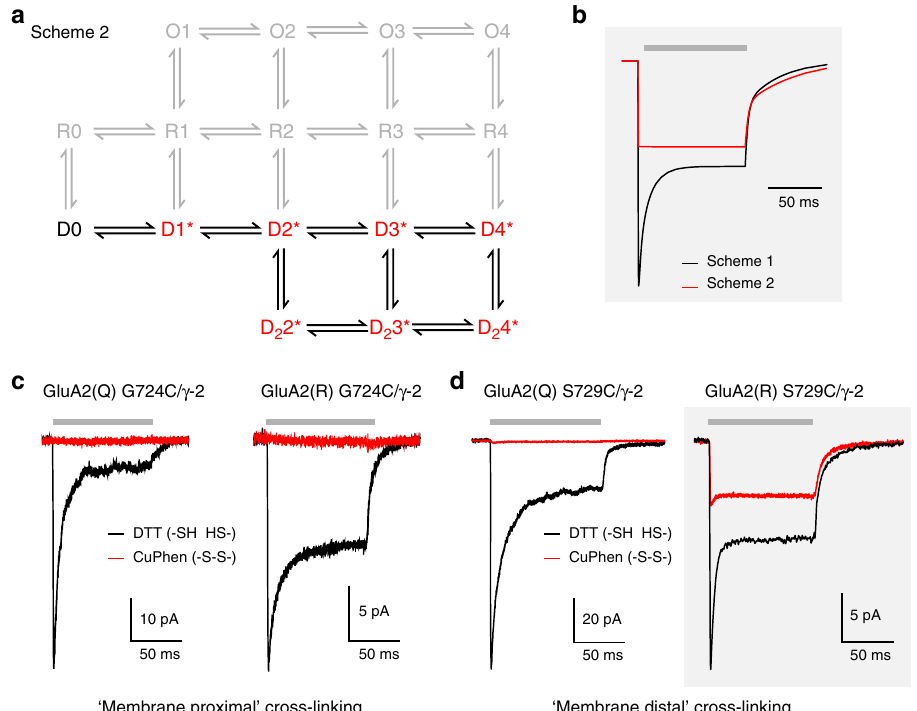
Fig. 6 A model with access to only desensitized states predicts behavior of cross-linked GluA2(R) S729C/ γ -2. a Scheme 2 is modi fi ed from Scheme 1 (Fig. 5a) and assumes that, following cross-linking, the receptor can occupy only desensitized states (excluded states are shown in gray). b Simulated responses to 10 mM glutamate (gray bar) using Scheme 1 to mimic the non-cross-linked condition and Scheme 2 to mimic the effect of cross-linking. c Representative currents at – 60 mV activated by 10 mM glutamate (gray bar) from GluA2(Q) G724C/ γ -2 and GluA2(R) G724C/ γ -2 in DTT (black) or CuPhen (red). Note that, for both forms, currents are fully inhibited following cross-linking by 10 µ M CuPhen. d Representative responses from individual patches demonstrate that following cross-linking by 10 µ M CuPhen, GluA2(Q) S729C/ γ -2 currents are inhibited, while GluA2(R) S729C/ γ -2 currents show minimal desensitization and continue to display a large steady-state current, as predicted in a . Gray boxes ( b and d ) highlight the similarity of modeled currents and recorded GluA2(R) S729C/ γ -2